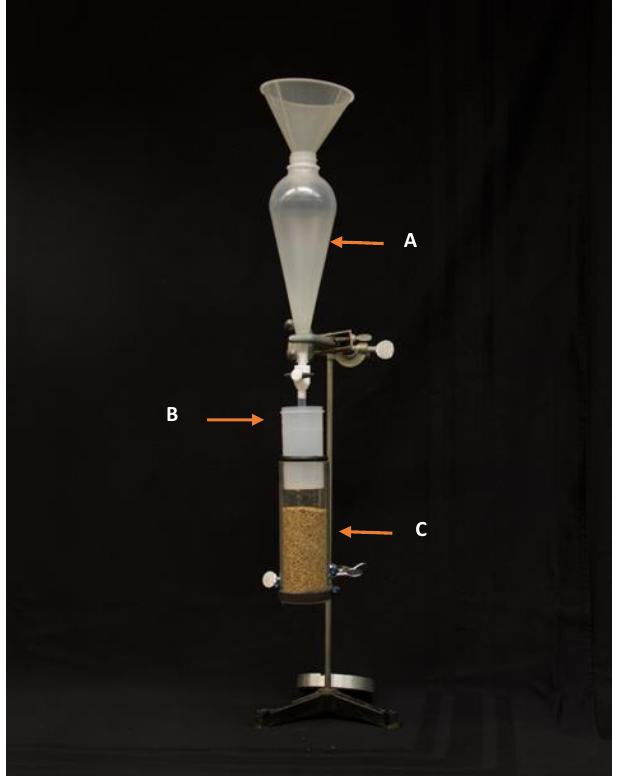
Figure 1. Surface irrigation apparatus. ( A ) Funnel, sparatory funnel with stopcock. ( B ) Water diffuser with O-ring above cylinder. ( C ) Sample cylinder with 200 mL of substrate.